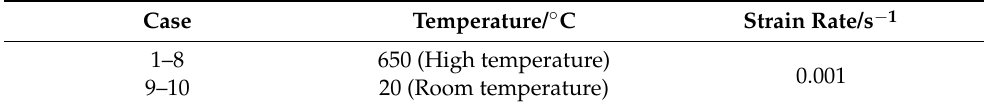
Table 2. Tensile experimental